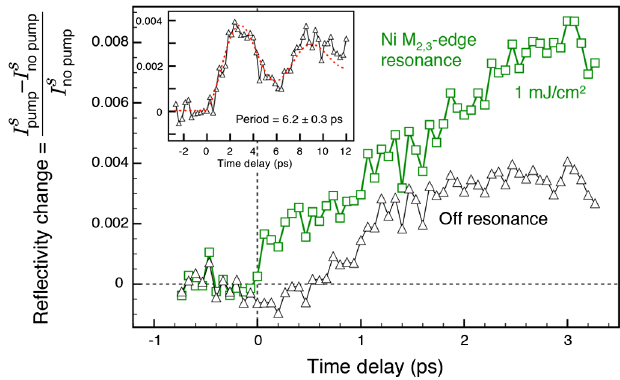
FIG. 4. Nonmagnetic reflectivity for a pump fluence of 1 mJ = cm 2 , measured by use of an s -polarized XUV probe beam both near ( h(cid:1) ¼ 67 : 7 (cid:3) 0 : 5 eV , green squares) and far from ( h(cid:1) ¼ 44 : 6 (cid:3) 0 : 3 eV , black triangles) the Ni M The maximum nonmagnetic artifact to the asymmetry can be inferred from this resonance reflectivity measurement (Fig. 3). We attribute the reflectivity dynamics at slower time scales in excess of a picosecond (inset) to the presence of a longitudinal acoustic wave that is launched by the absorption of pump-pulse energy by the periodic diffraction grating. By definition, the asymmetry parameter is unaffected by this phonon contribution because it results only in the modulation of the diffraction- grating